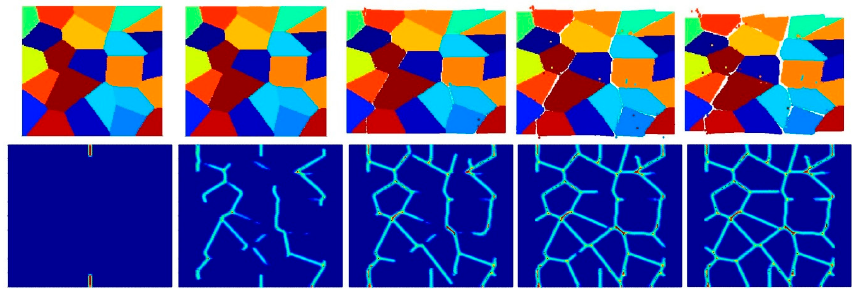
Figure 23. Fracture pattern of polycrystal when β = 0.5 with 25 grains in total. From left to right: time = 1.5 μ s, 2.0 μ s, 2.5 μ s, 3.0 μ s, and 3.5 μ s, respectively.